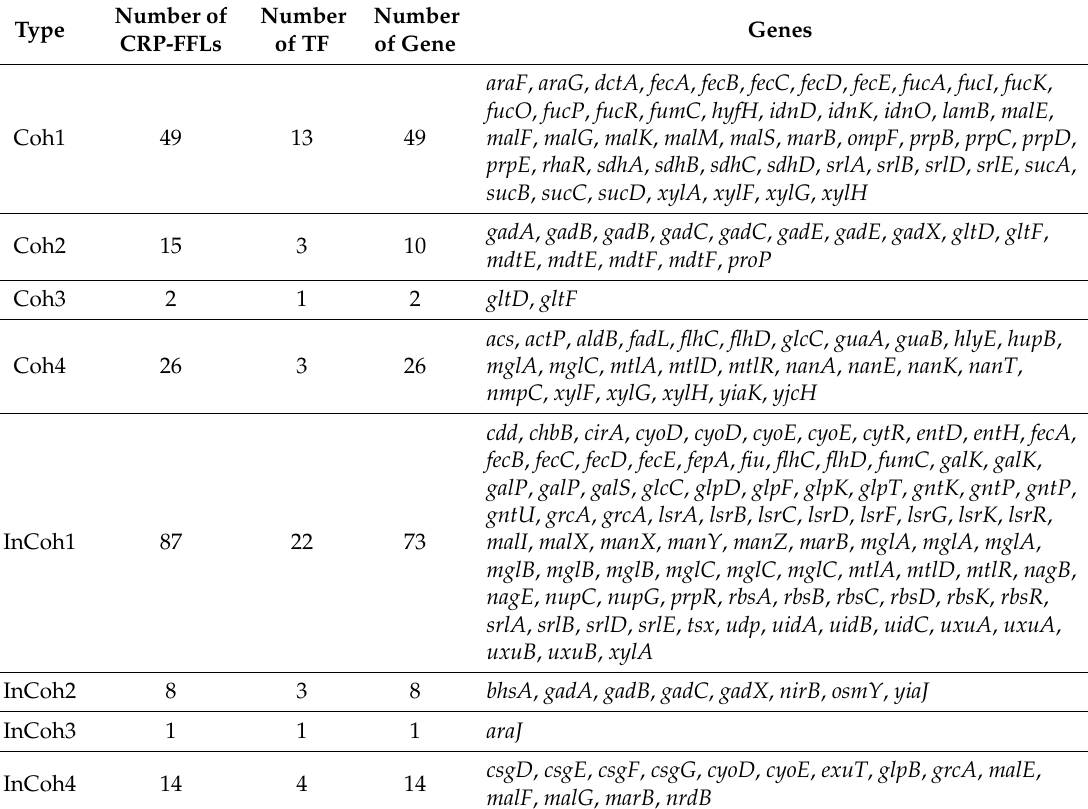
Table 1. Data statistics for each type of CRP-FFL. The detailed numbers of CRP-FFLs, transcription factors (TFs) and genes are listed for each type of CRP-FFL. A number of target genes regulated by multiple TFs and TF-regulated multiple genes are also listed. Target genes for each type of CRP-FFL are listed for further